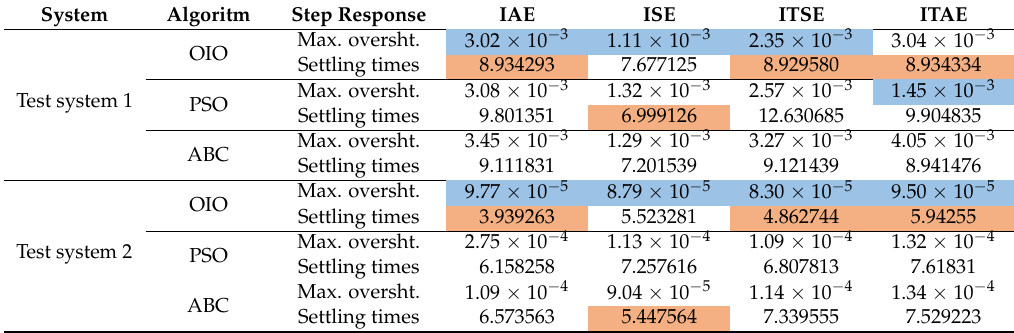
Table 4. Settling times and maximum overshoots of the frequency deviation of the control